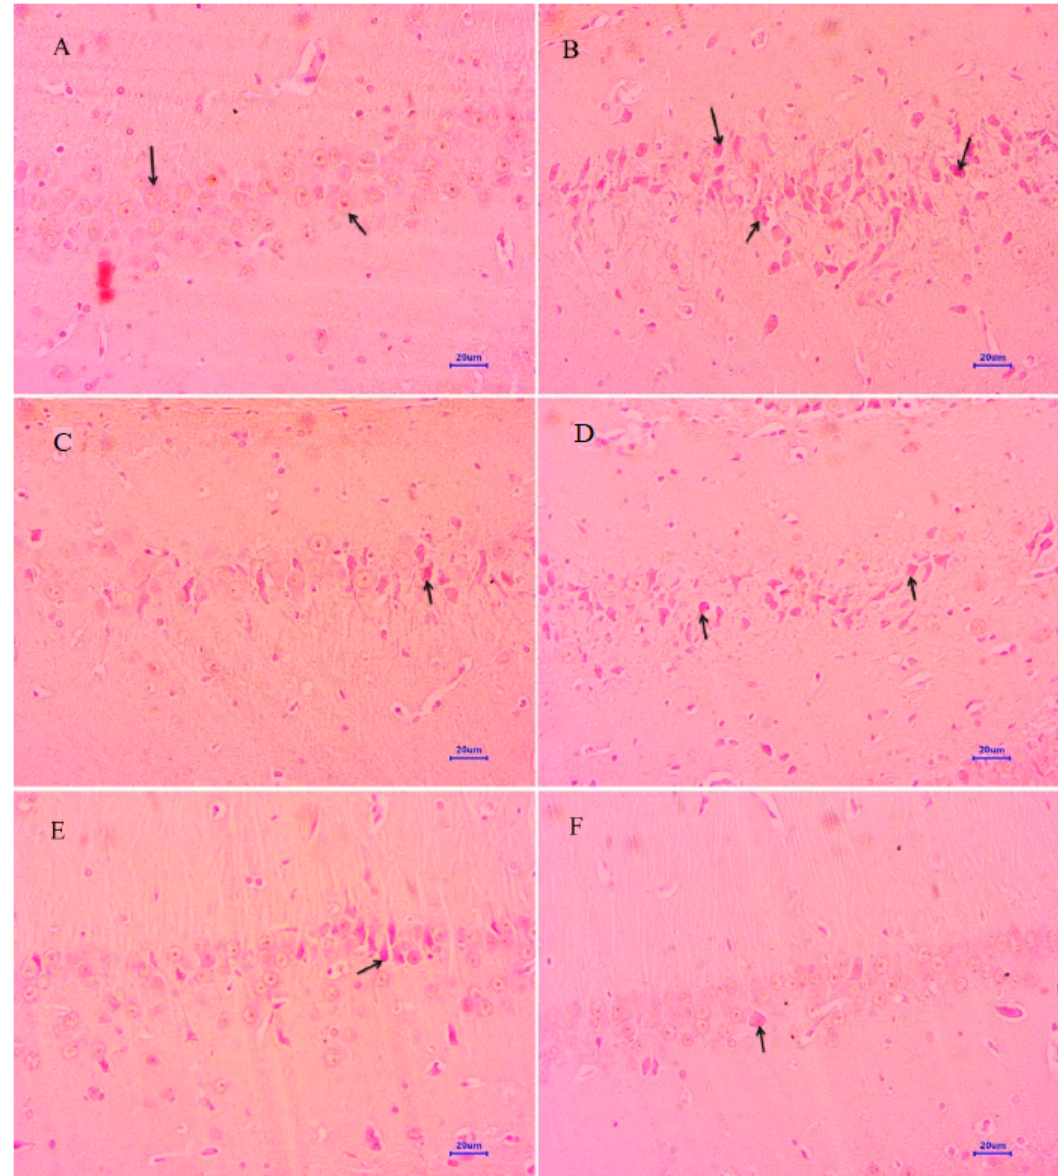
Figure 10. Effect of quercetin and quercetin administered with memantine on Congo red-stained hippocampus tissue (400 × ). ( A ): Normal control, ( B ): Disease control, ( C ): Memantine (20 mg/kg), ( D ): Quercetin (50 mg/kg), ( E ): Memantine + quercetin (20 + 25 mg/kg), ( F ): Memantine + quercetin (20 + 50 mg/kg).